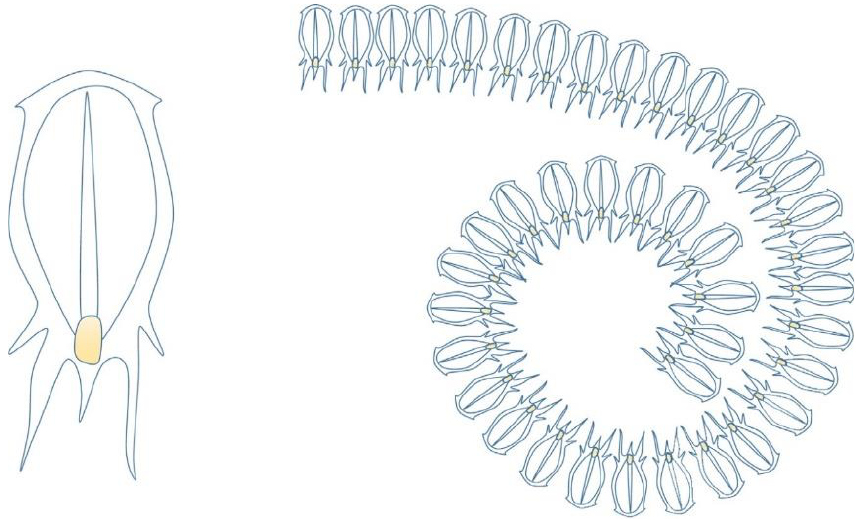
Figure 2. Individual salp and salp chain.